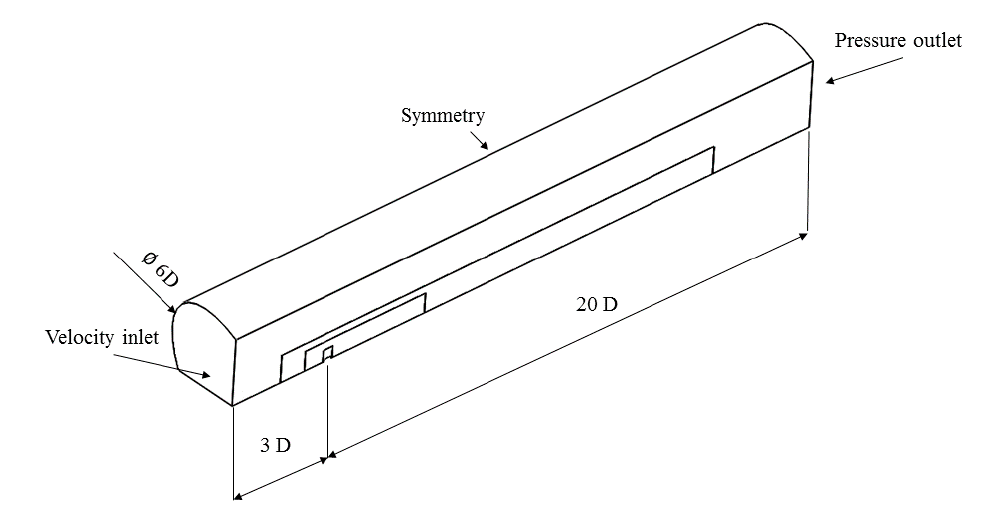
Figure 5. Computational domain.